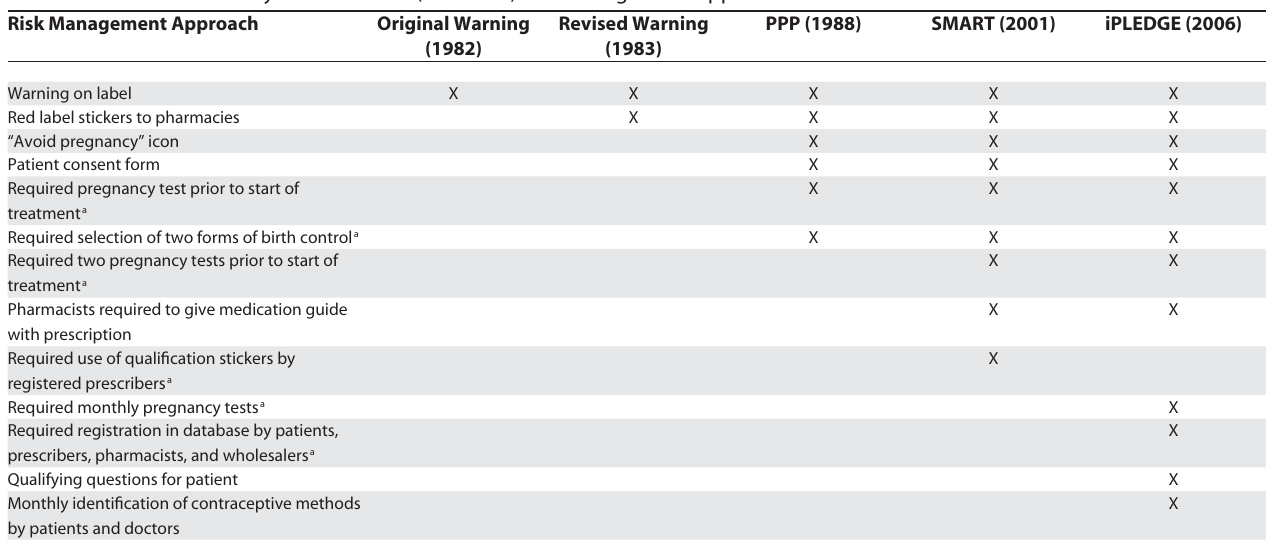
Table 1. Overview of History of Isotretinoin (Accutane) Risk Management Approaches Risk Management